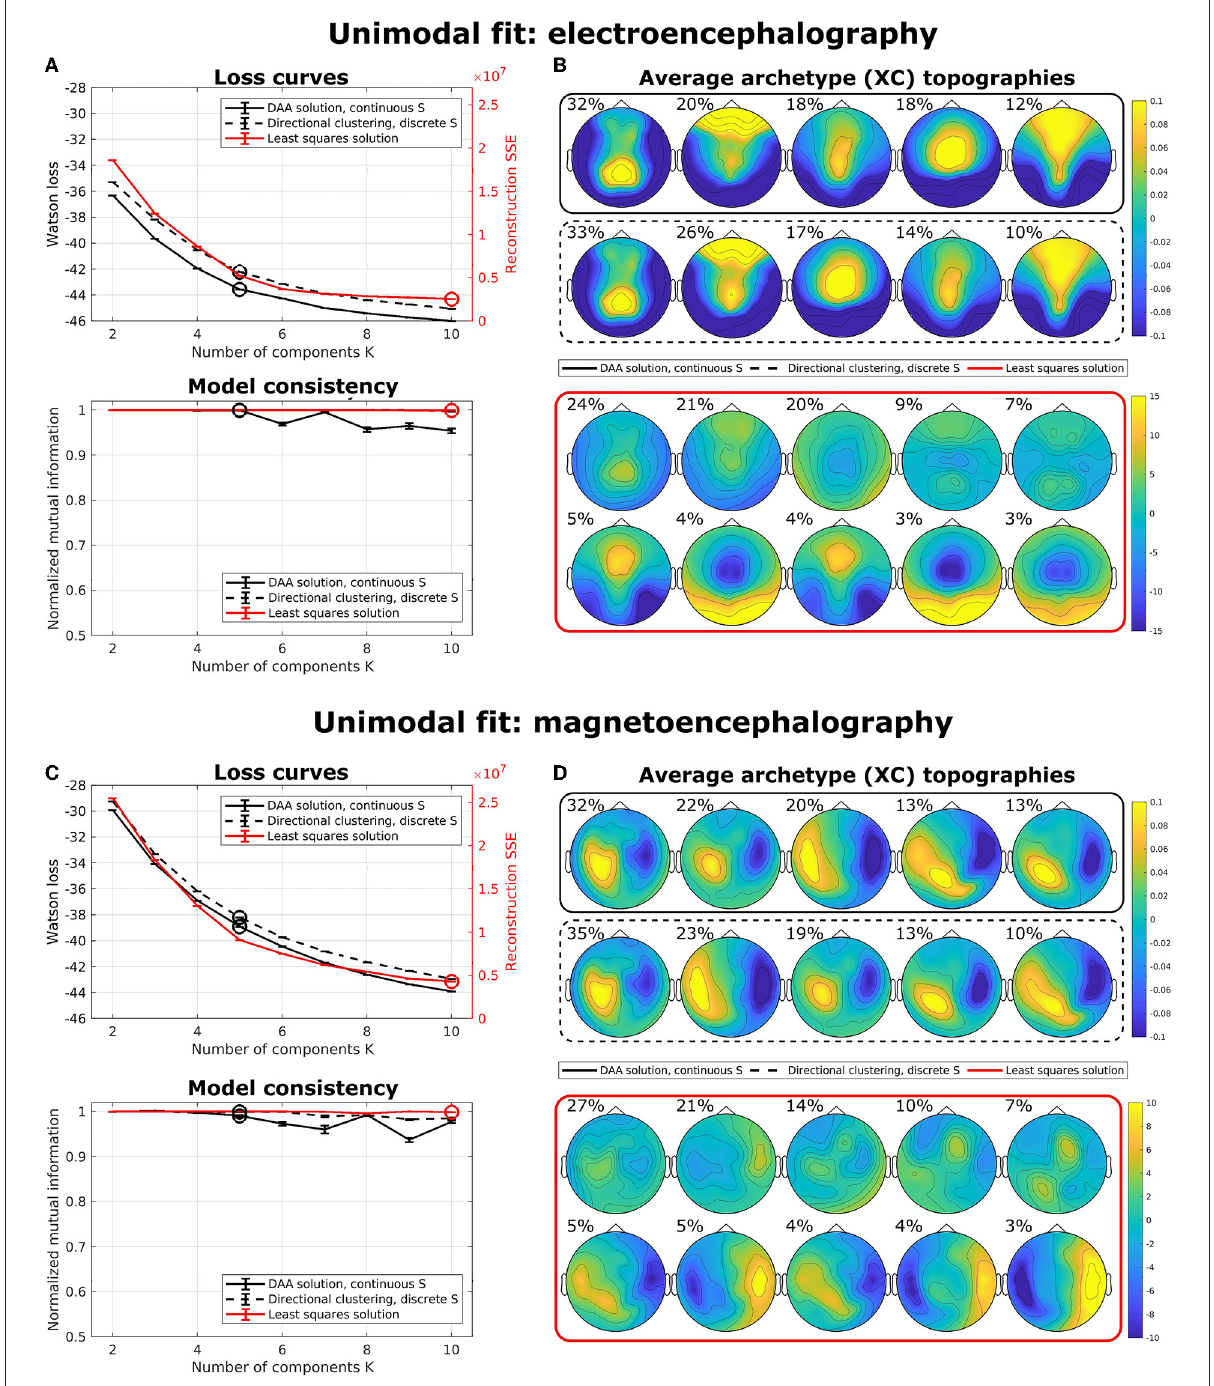
FIGURE3 Unimodal multisubject archetypal analysis fits using DAA, conventional Euclidean archetypal analysis, and a directional clustering model derived from DAA using hard class assignment. (A,C) Loss curves and model consistency evaluated using NMI evaluated on 5 models, where each is the best of 100 model fits. Error bars represent standard error of the mean. (B,D) Archetype topographical maps for the best model fits with K and K 10 for the directional models and the Euclidean model for EEG and MEG data, respectively. Archetypes are averaged across subjects = and are ordered according to the total occupation of the archetypal mixing matrix S